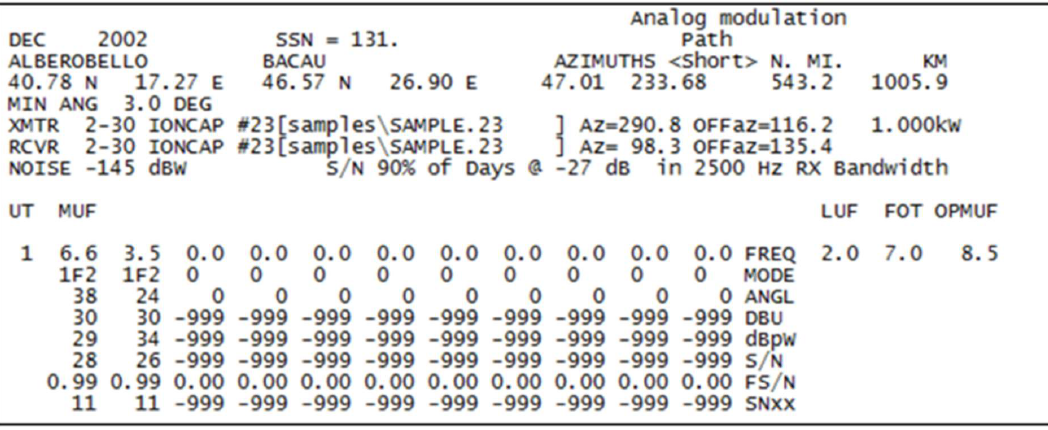
Fig. 4. Shows sample of REC533 predicted